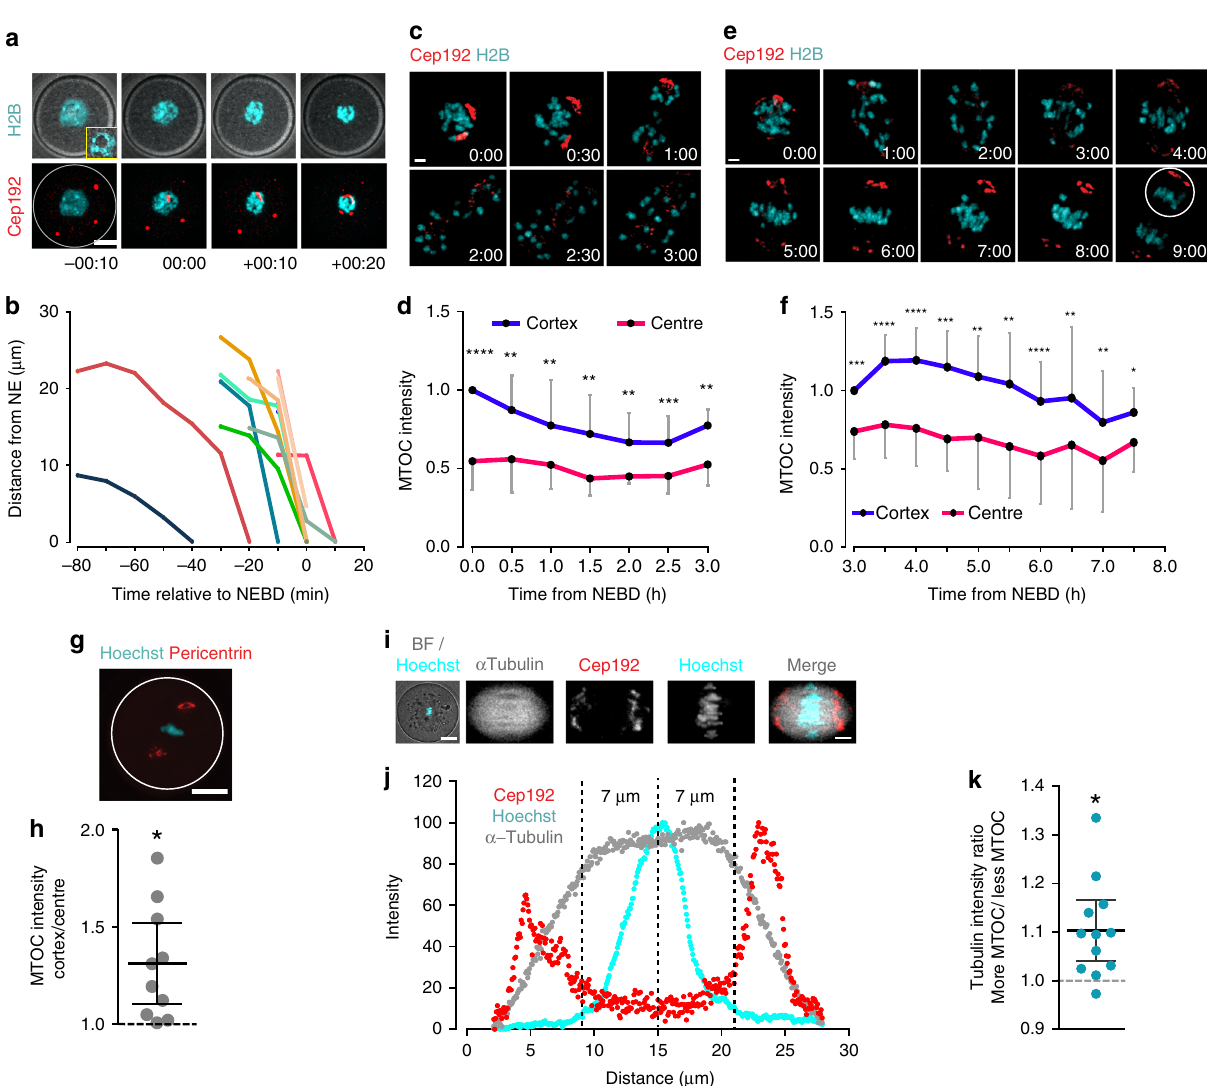
Fig. 6 MTOC asymmetry is established at NEBD. a , b Representative images ( a , Cep192-GFP, red; H2B-mCherry, cyan) and trajectory plots ( b ) of MTOCs from the oocyte cortex to centre ( n = 9, from two independent experiments). Bright fi eld inset, shows single z-slice with a ‘ surrounded nucleolus ’ (SN) con fi guration. Time is relative to NEBD (hh:min), and distances are measured relative to the nuclear envelope. Scale bar: 20 μ m. c , d Representative time- lapse imaging ( c ) and spindle pole intensities ( d ) of MTOCs in oocytes ( n = 9, from three independent experiments) expressing Cep192-GFP and H2B- mCherry from 0 to 3 h after NEBD. The MTOC fl uorescence intensity at both poles was calculated at 30 min intervals. Scale bar is 5 μ m. e , f Representative time-lapse imaging ( e ) and spindle pole intensities ( f ) of MTOCs in oocytes ( n = 11; from three independent experiments), as for ( b , c ) between 3 and 8 h after NEBD. Scale bar is 5 μ m. g Representative z-projection of an oocyte stained for pericentrin (red) and Hoechst (cyan). White circle depicts position of plasma membrane. Scale bar is 20 μ m. h The ratio of cortical and central MTOC intensities at 6 h after NEBD from oocytes in ‘ g ’ (oocytes from two independent experiments). i Representative image of a spindle ( α -tubulin-GFP grey; Cep192-mCherry, red; Hoechst, cyan), at 4 h after NEBD, showing its central position within the oocyte. Scale bar: 20 and 5 μ m. j Intensity pro fi les along the long spindle axis of Cep192, Hoechst and α -tubulin from the image in ‘ i ’ . Dashed lines show the weighted centre of intensity of the chromatin and 7 µ m either side. k Ratio of the tubulin fl uorescence in the regions indicated in ‘ j ’ ; measurements from two independent experiments. The spindle sides are de fi ned by having either more or less MTOC (Cep192) signal as shown in ‘ j ’ . ( d , f ) * P < 0.05; ** P < 0.01; *** P < 0.001; **** P < 0.0001, paired t -test, two-tailed; error bars are s.d. ( h , k ) * P < 0.05; plots show mean line (with an n = 10 ‘ h ’ and 12 ‘ k ’ oocytes) and error bars that are 95% con fi dence